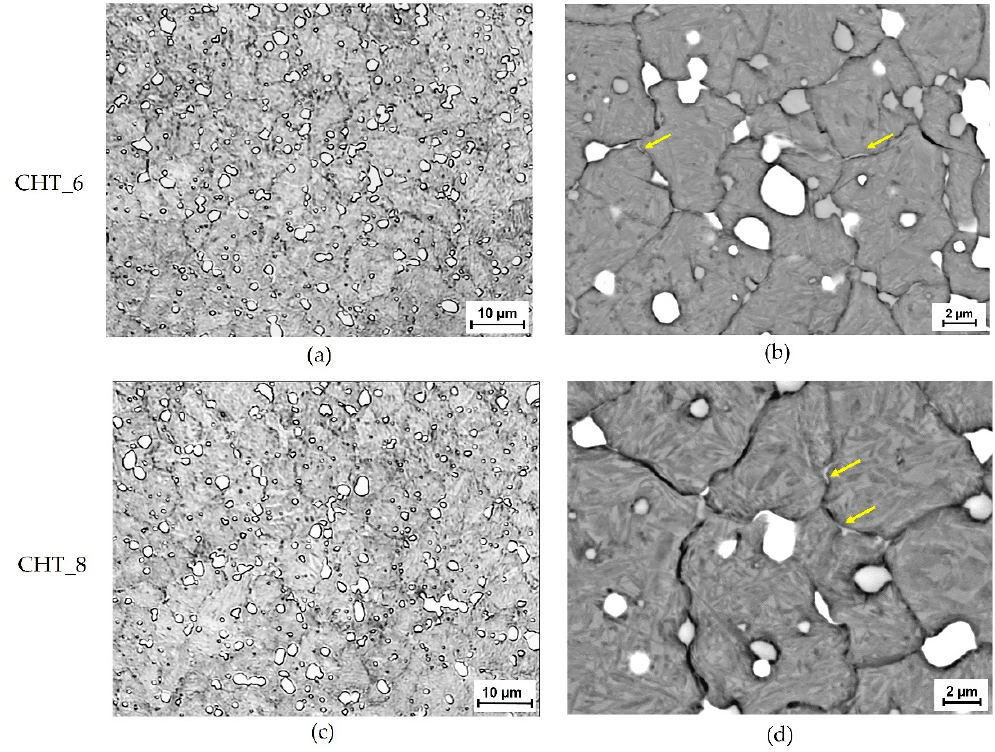
Figure 7. ( a , c ) Optical and ( b , d ) BSE-SEM micrographs of the microstructure observed on the cross-section of taps after CHT_6 and CHT_8 heat treatments. Yellow arrows in ( b , d ) show the semi-continuous distribution of proeutectoid carbides visible along prior austenitic grain boundaries.